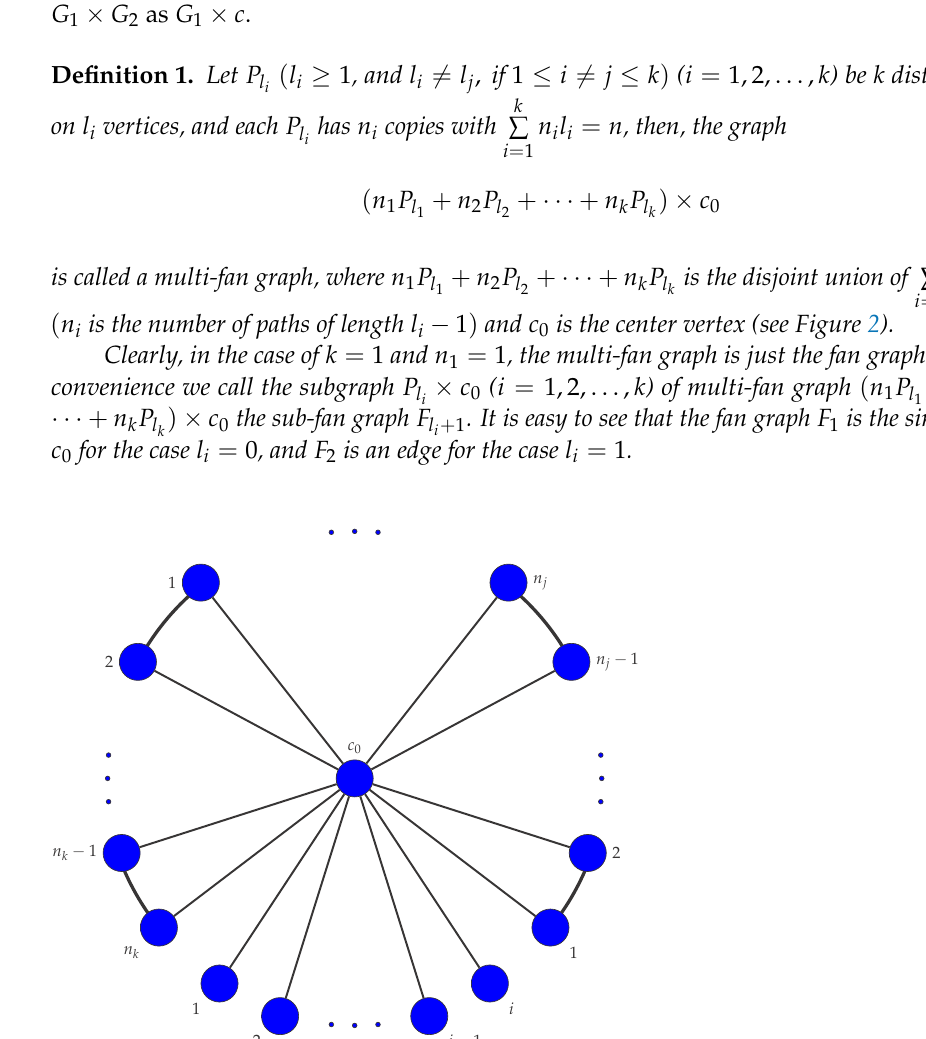
Figure 2. The multi-fan graph ( iP 1 + P n